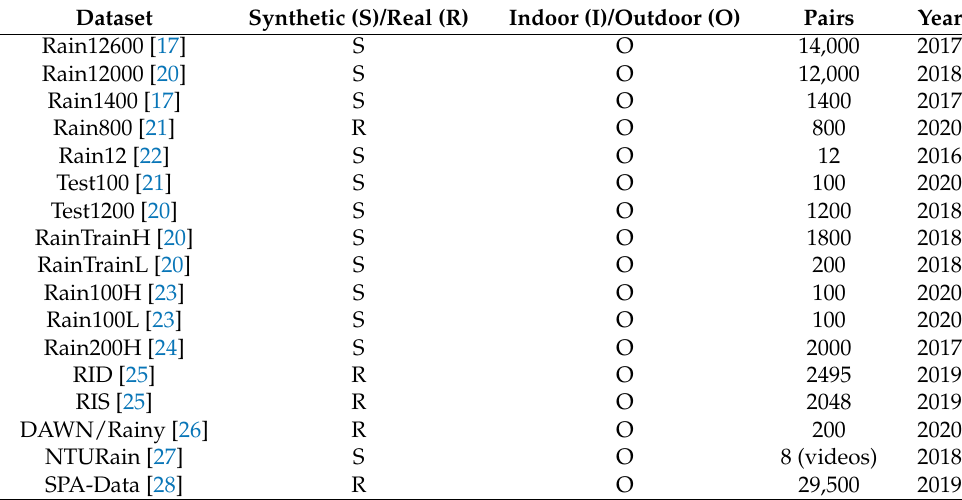
Table 1. Listing of datasets used for the deraining task.